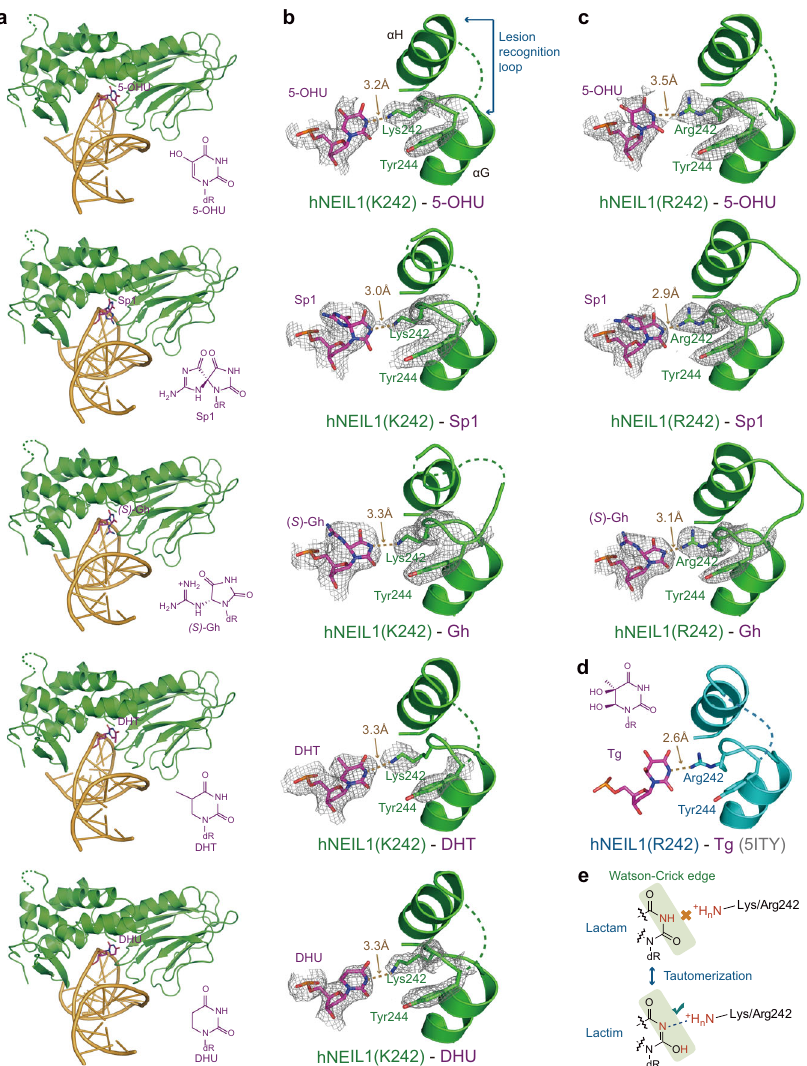
Fig. 1 Tautomerization-dependent recognition of diverse substrates by hNEIL1. a Overall views of hNEIL1(K242) bound to double-strand DNAs containing a 5-OHU, Sp1, ( S )-Gh, DHT, or DHU. The chemical structures of individual damaged bases are shown in purple. b Zoom-in views of the interaction mode for hNEIL1(K242) in complex with various damaged bases. The lesion recognition loop located between α G and α H is indicated. The 2Fo − Fc simulated-annealing composite omit electron density map is shown in gray mesh and contoured at 1.0 σ for both damaged bases and key loop residues. The gold dashed line represents hydrogen bond interaction. The dashed curve stands for an unbuildable short region of the lesion recognition loop due to ambiguous electron density. c The 242-in loop conformation was again observed in the crystal structure of a naturally existing variant hNEIL1(R242) in complex with 5-OHU, Sp1, and ( S )-Gh, respectively. d The previously reported hNEIL1(R242)-Tg structure (PDB code: 5ITY) also shows a 242-in conformation, consistent with the all above described hNEIL1 – DNA complexes. e The tautomerization-dependent hydrogen bonding between the fl ipped bases and residue 242 of hNEIL1. The base tautomers are denoted with the lactam (upper) and lactim (lower) (Fig. 2a). To rule out the possibility that the observed interaction Different from the 242-in loop conformation described pre- viously, in the structures of hNEIL1(R242)-DHU and hNEIL1 (R242)-DHT, R242 residue moves away from the fl ipped bases while Y244 moves in and stacks against DHU/DHT, burying the nucleobase in a hydrophobic enclosing (Fig. 2a and Supplemen- tary Fig. 3d, e) (termed as the “ 244-in ” conformation). Such a conformational change is reminiscent of the “ DFG fl ip ” well- known for protein kinases, in which key amino acid residues in a fl exible loop can switch their relative positions 40,41 . The 244-in conformation of lesion recognition loop is also different from that in the hNEIL1 free protein ( apo conformation), where the loop rotates for ~40° (using Gly240 and Gly249 as turning points) to stay far away (>9 Å) from the position of the fl ipped base